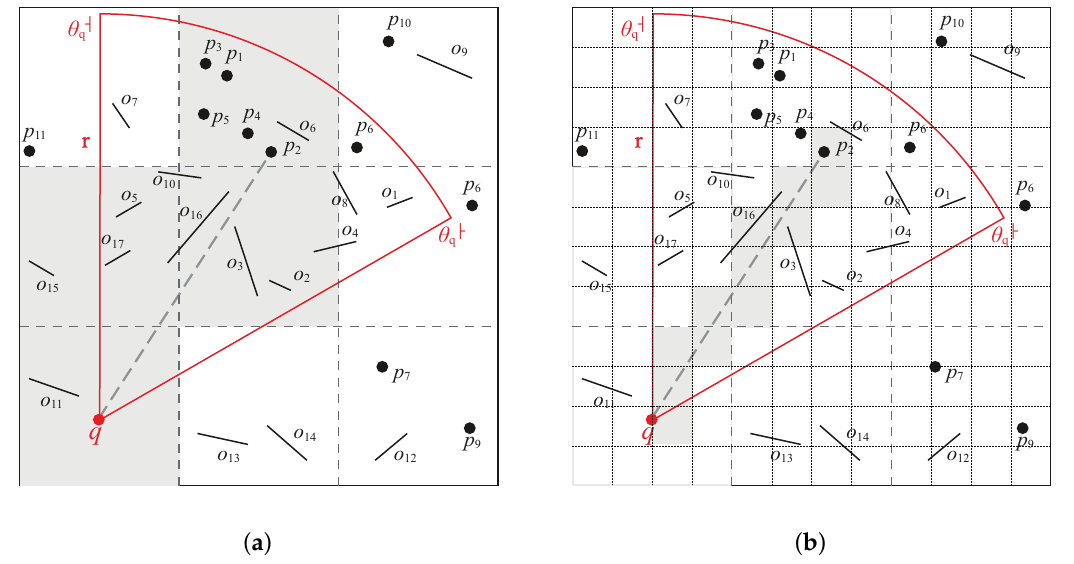
Figure 16. ( a ) A coarse granularity grid. ( b ) A fine granularity